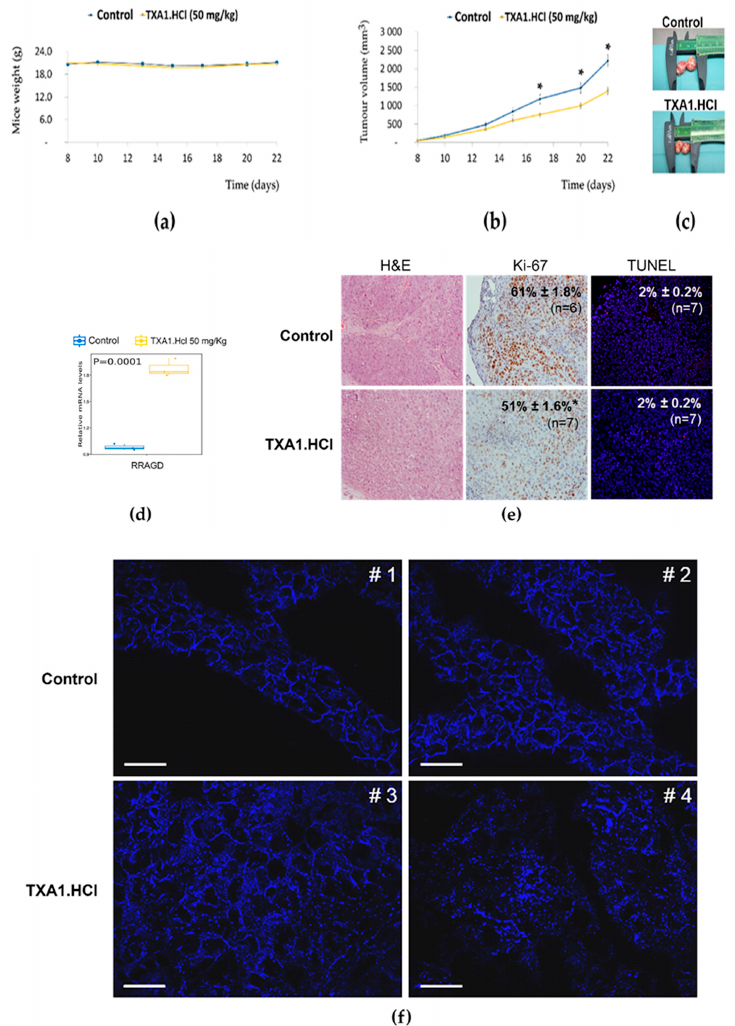
Figure 9. TXA1.HCl decreases tumor growth and proliferation and affects cholesterol localization and RAGD expression in NCI-H460 tumor xenografts in nude mice. Nude mice bearing tumor xenografts (40–80 mm 3 ) were s.c. injected three times per week with TXA1.HCl (50 mg/kg, n = 7) or vehicle control (saline, n = 7). ( a ) Body weight changes in mice during treatment. Results are expressed as the mean ± SEM, n = 7. * p < 0.05 vs. control. ( b ) Tumor growth